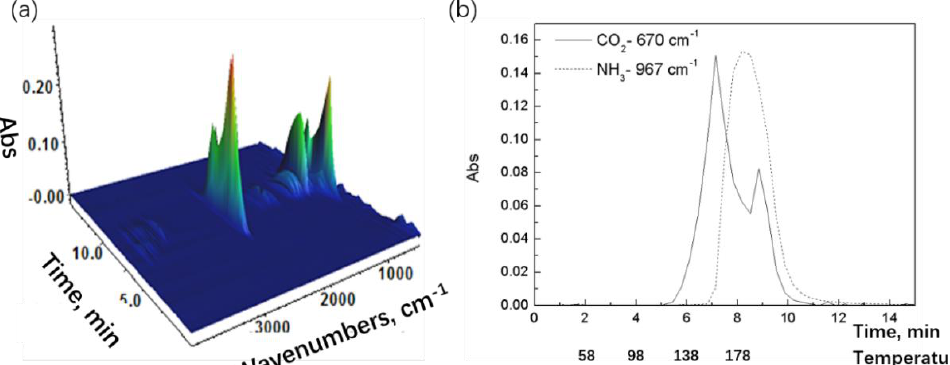
Figure 2. ( a ) Three-dimensional (3D) thermogravimetric (TG)-FTIR spectra and ( b ) absorbance of characteristic peaks vs. time / temperature. Table 1. Identification of major gaseous species through characteristic IR bands.